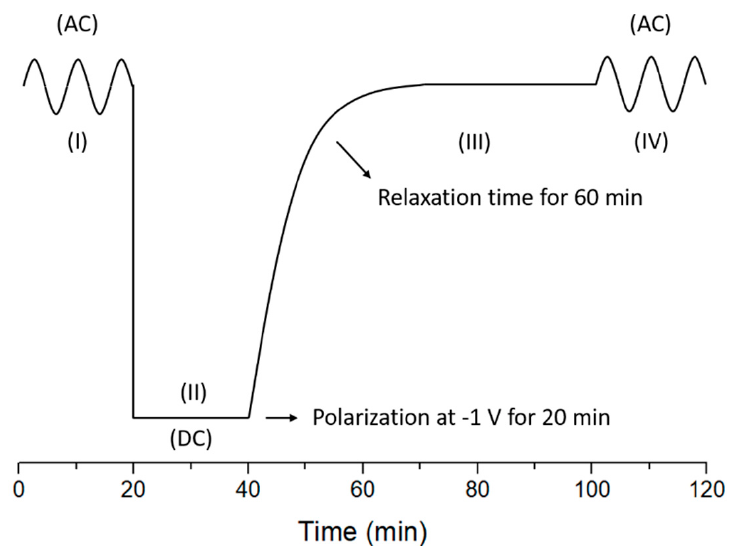
Figure 1. Schematic of the AC–DC–AC (alternating ‐ direct ‐ alternating current method ) test procedure